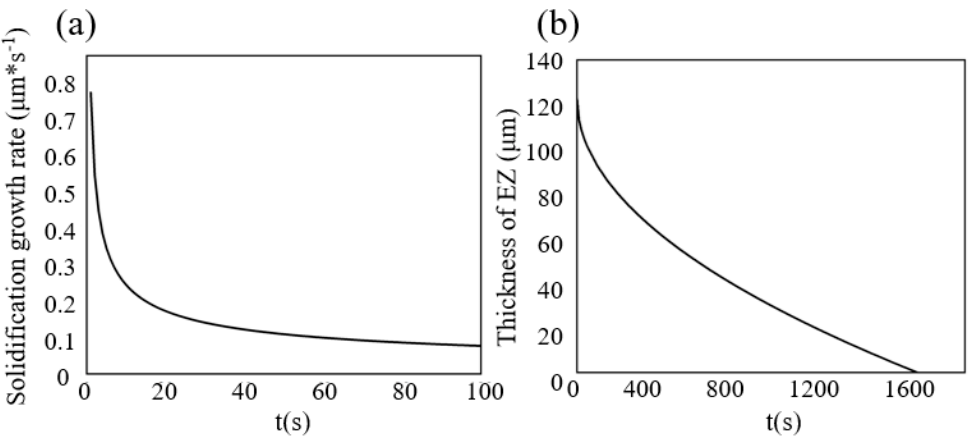
Figure 12. Effect of holding time on ( a ) the solidification growth rate and ( b ) the thickness of EZ. The rate of isothermal solidification dropped to a small value after a certain time and remained stable. The variation curve of EZ thickness with holding time at 1160 °C was drawn, as shown in Figure 12b. With the increase of time, the slope absolute value of the curve was smaller, which means that the liquid phase isothermal solidification rate decreased. From Equation (6), the isothermal solidification time can be expressed as follows: